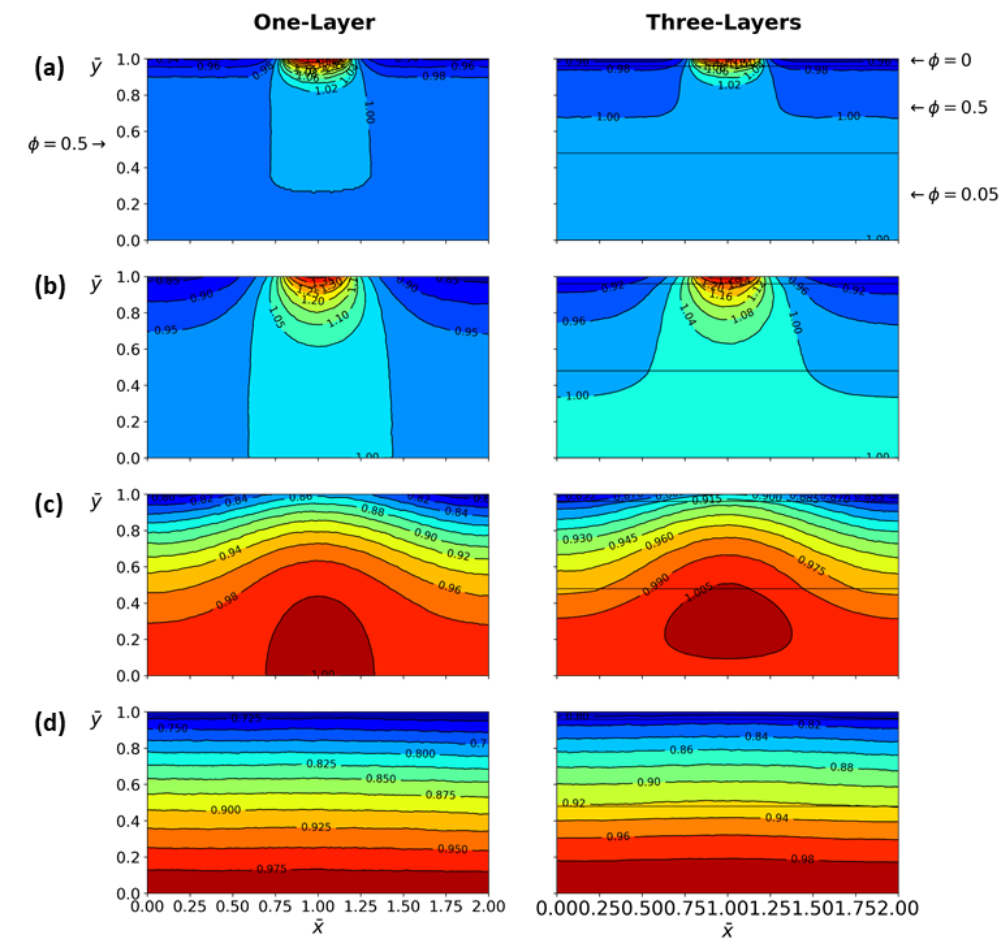
Figure 17. Comparison of the temperature distribution for one-layer tissue with φ = 0.5 and three- layer tissue with φ = 0, 0.5, and 0.05 for epidermis, dermis, and hypodermis, respectively. For different times from top to bottom ( a ) τ = 0.01, ( b ) τ = 0.09, ( c ) τ = 0.2, and ( d ) τ = 0.45. For a non-Newtonian fluid, n =